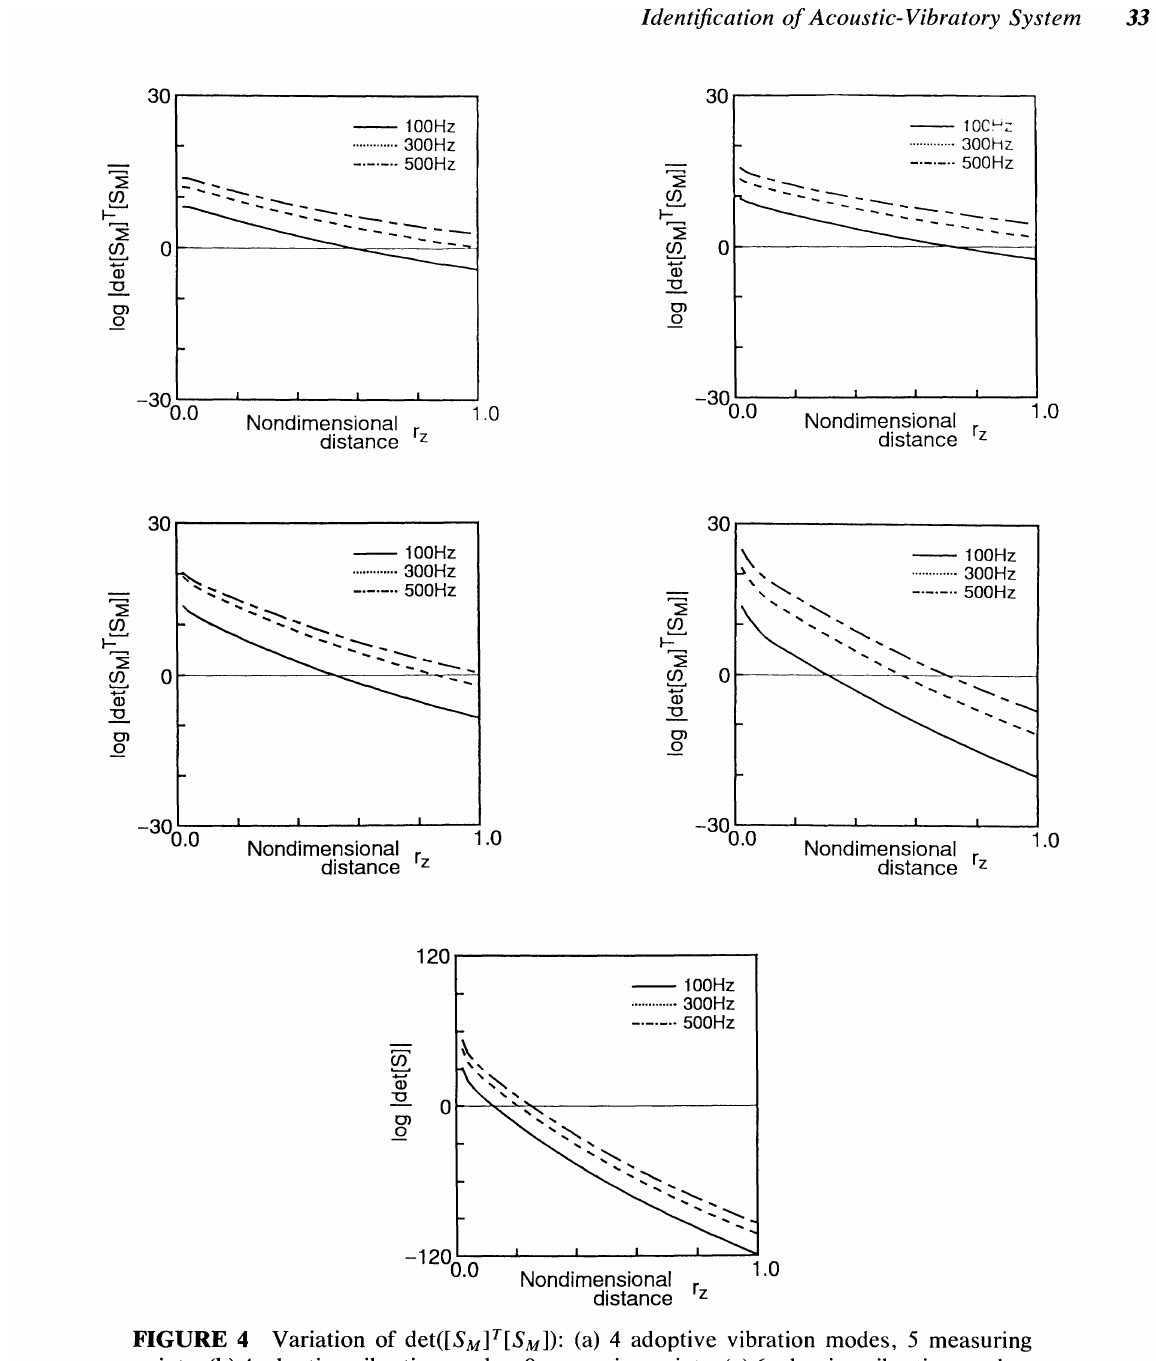
FIGURE 4 Variation of det([SMV[SM]): (a) 4 adoptive vibration modes, 5 measuring points; (b) 4 adoptive vibration modes, 9 measuring points; (c) 6 adoptive vibration modes, 9 measuring points; (d) 8 adoptive vibration modes, 9 measuring points; and (e) BEM direct method, 32 measuring